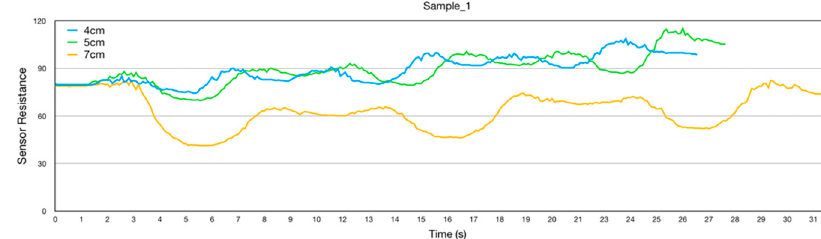
Figure 11. Results of sample 1.